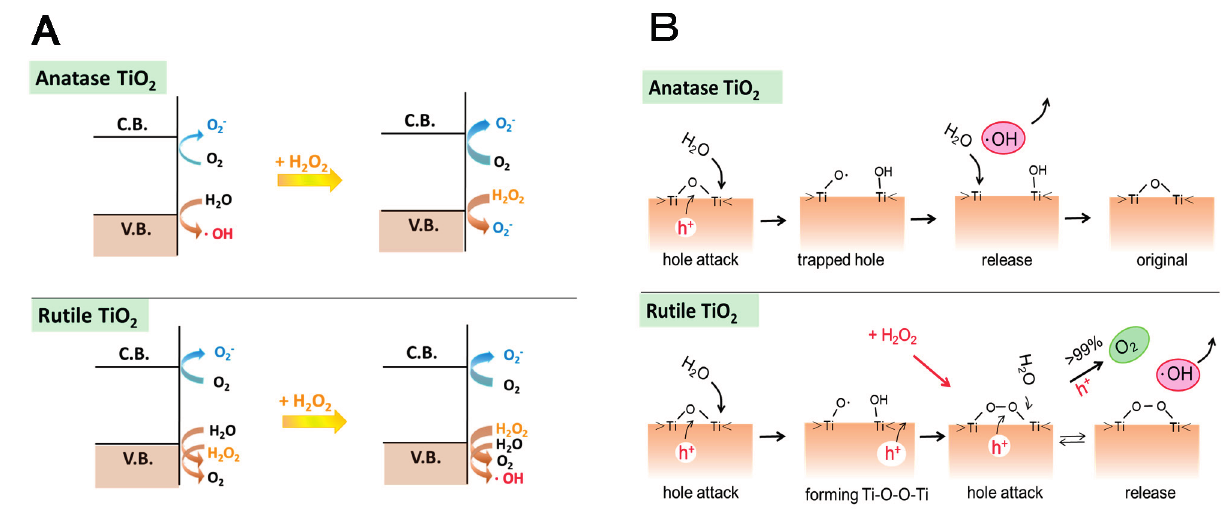
Figure 12. ( A ) Photocatalytic processes at the conduction band (C.B.) and the valence band (V.B.) of TiO 2 with anatase and rutile crystalline types in the absence and the presence of H 2 O 2 . The thickness of arrows expresses the degree of the reaction rate; ( B ) Plausible mechanisms of •OH generation at anatase TiO 2 (upper part) and rutile TiO 2 (lower part). Reprinted with permission from [36]. © 2014 American Chemical